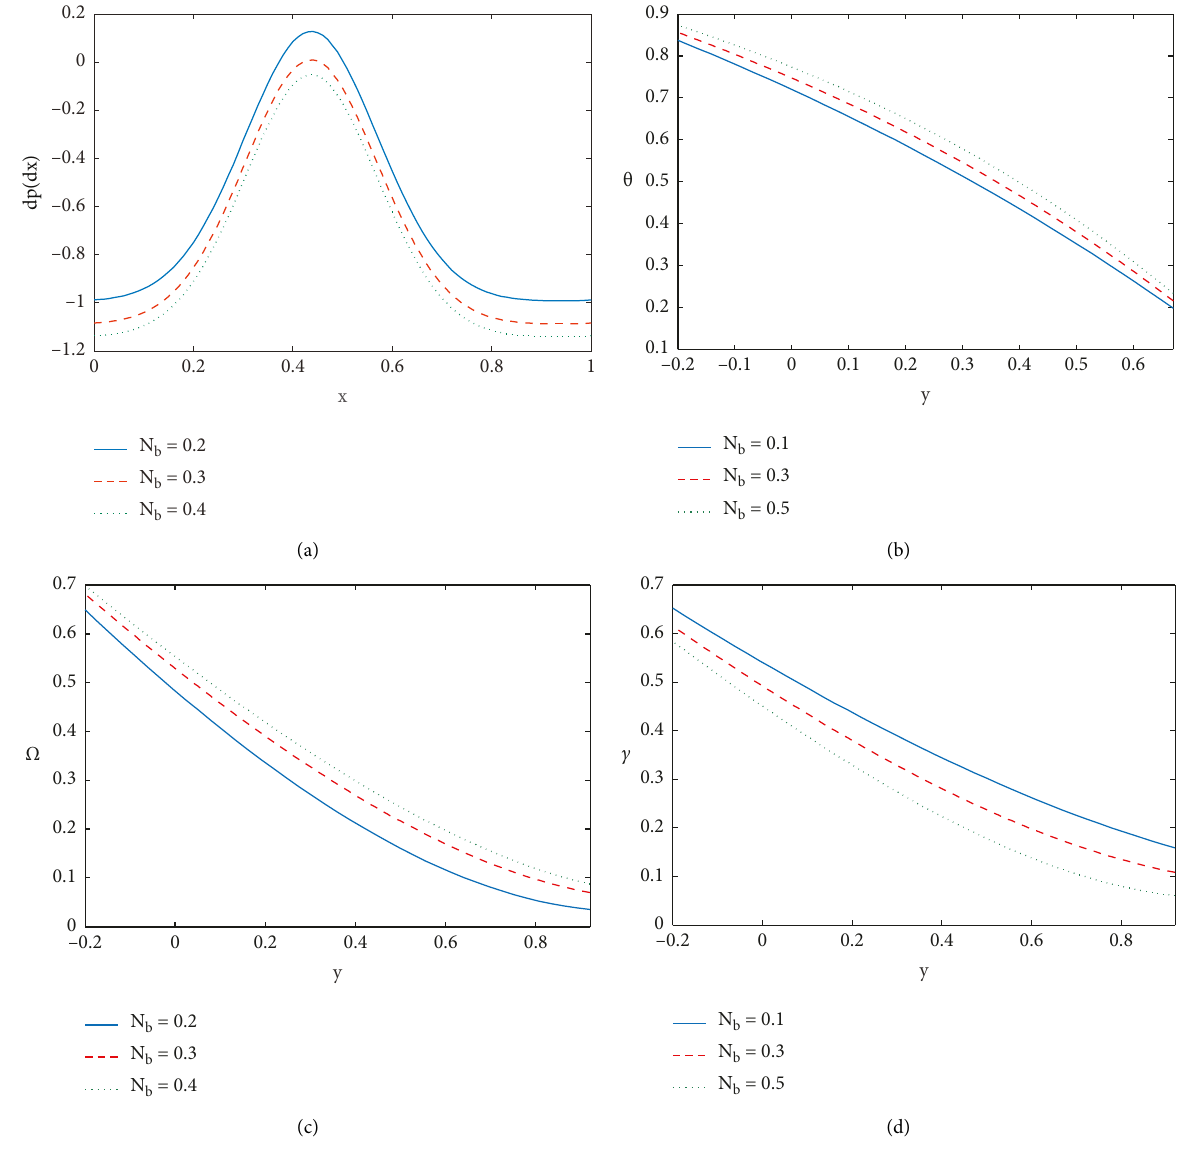
Figure 5: Effects of N